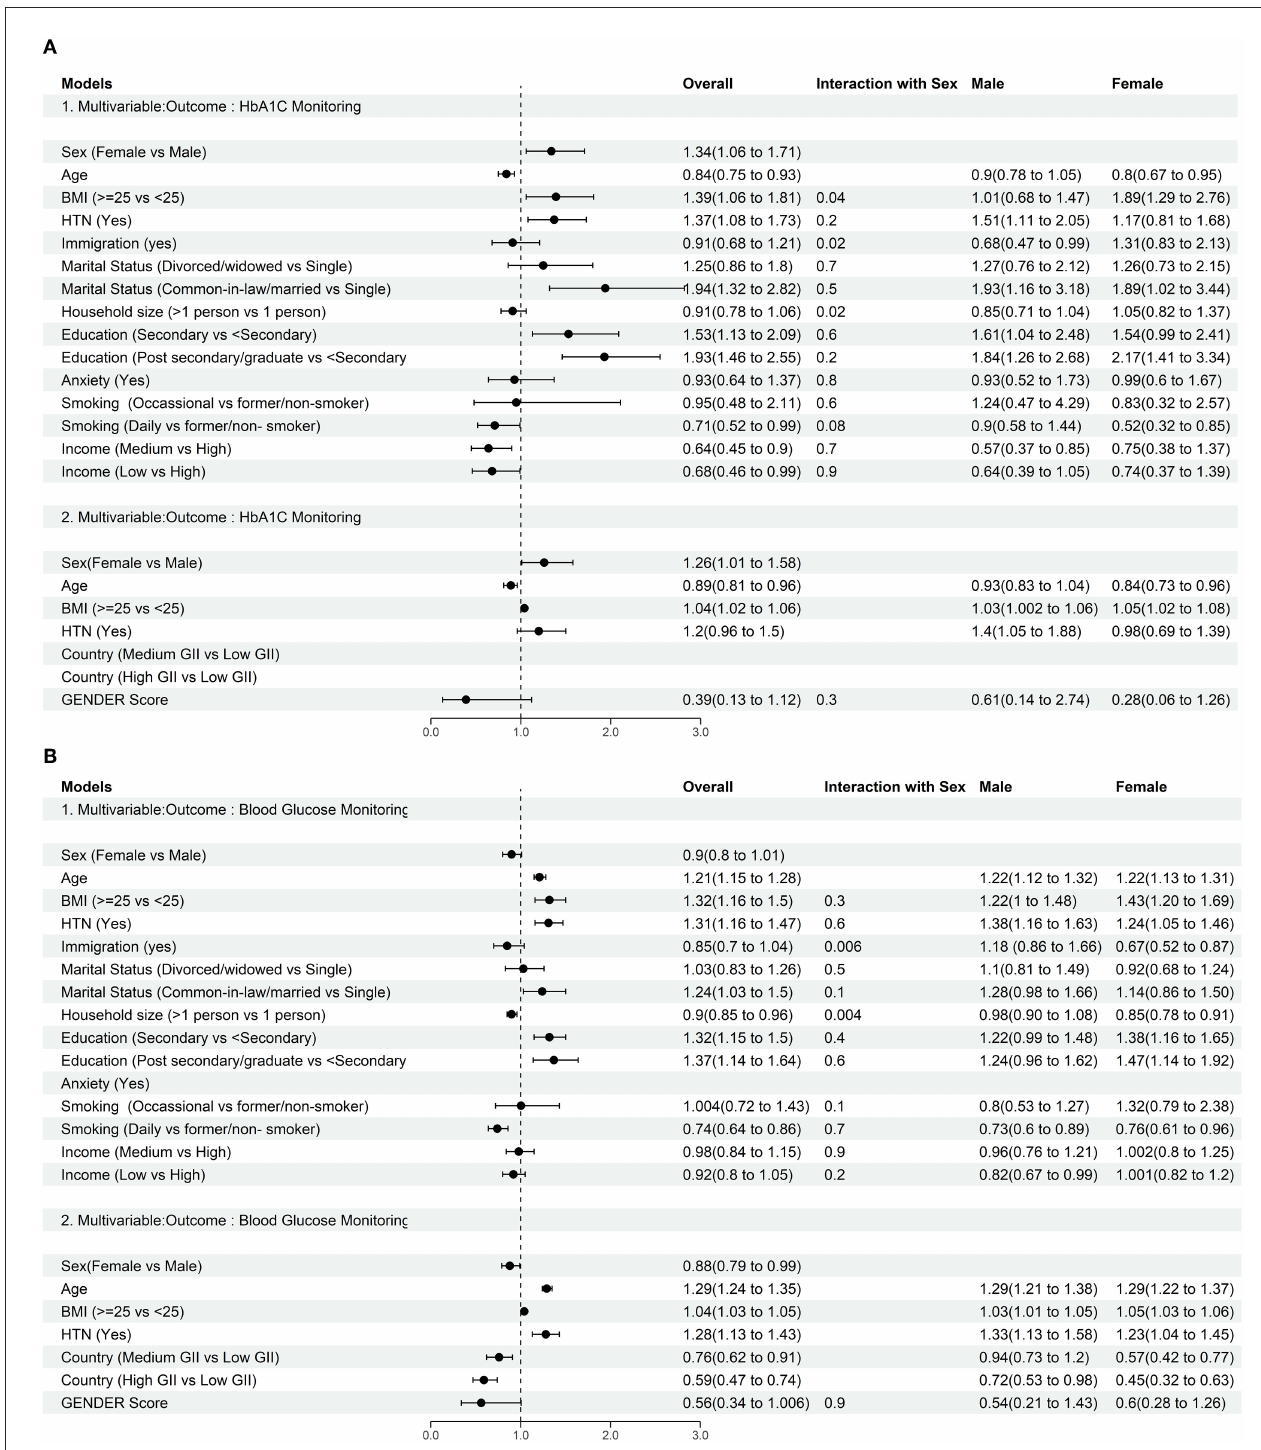
FIGURE3 (A) Forest plot: Assessing role of biological sex and gender variables in care of individuals with diabetes including rate of HbA1c monitoring by health care professional in the past 12 months in Canadian population: Results are presented as Odds Ratio (95% CI). Interaction between sex and gender was assessed via repeated sets of multivariable models including two-way interaction between each gender variable and sex. (B) Forest plot: Assessing role of biological sex and gender variables in care of individuals with diabetes including prevalence of blood glucose monitoring by health care professional in the past 12 months in European population: Results are presented as Odds Ratio (95% CI). Low GII Countries: GII < 0.077: Belgium, Denmark, Finland, Netherlands, Norway, Sweden, Slovenia; Medium GII Countries: GII: 0.077–0.1635: Austria, Cyprus, Czech Republic, Germany, Greece, France, Spain, Croatia, Ireland, Iceland, Italy, Luxemburg, Poland, Portugal, UK, Lithuania; High GII Countries: GII > 0.1635: Bulgaria, Estonia, Hungary, Malta, Romania, Slovakia, Latvia. Interaction between sex and gender was assessed via repeated sets of multivariable models including two-way interaction between each gender variable and